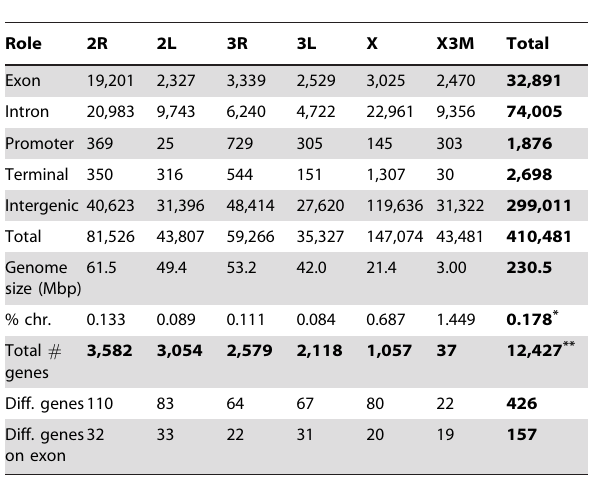
*Total proportion of significantly differentiated regions in relation to the total A. gambiae genome size (=273 Mbp) **The remaining genes 827 (=13,254– 12,427) belong to UNKN segment, a large segment that has not mapped to chromosome.